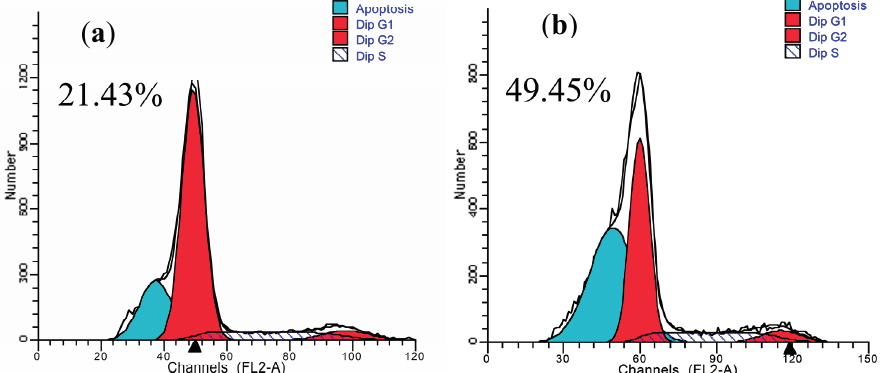
Figure 6. Effect of GSP, AAP IV, and their combination on apoptosis of splenocytes. ( a ) Normal group; ( b ) RT model group; ( c ) GSP (0.3 μ g/mL) group; ( d ) AAP